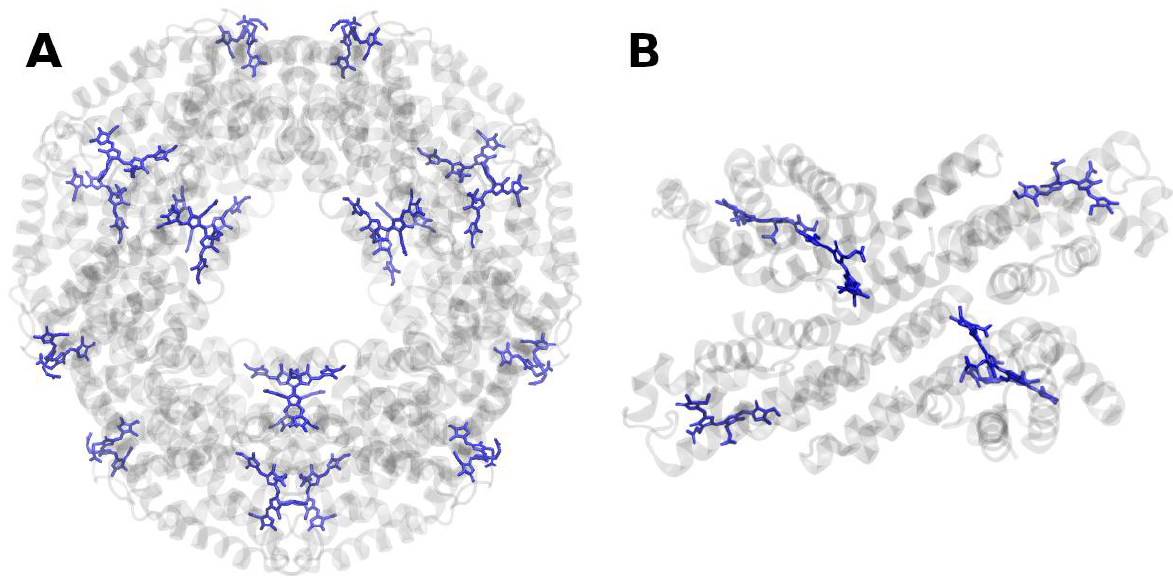
Figure 11. Structure of phycocyanin from Thermosynechococcus elongatus at 1.35 Å resolution, PDB entry 3L0F [115]. ( A ) View of the dodecamer along the phycobilisome stacking axis. ( B ) Side view of a tetrameric unit, perpendicular to the stacking axis. The protein backbone is shown in grey. Phycocyanobilins are shown in blue.